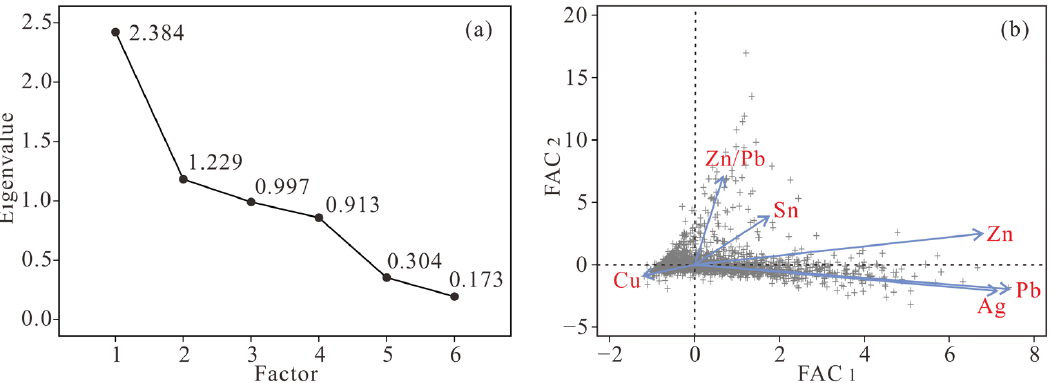
Figure 6. R-type cluster analysis results for the ore-forming elements.